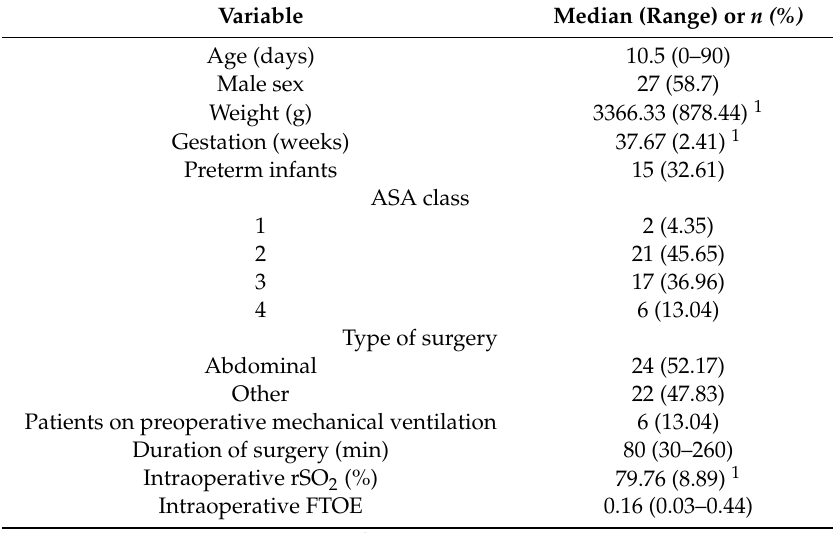
Table 1. Demographic and clinical characteristics of the studied infants ( n =